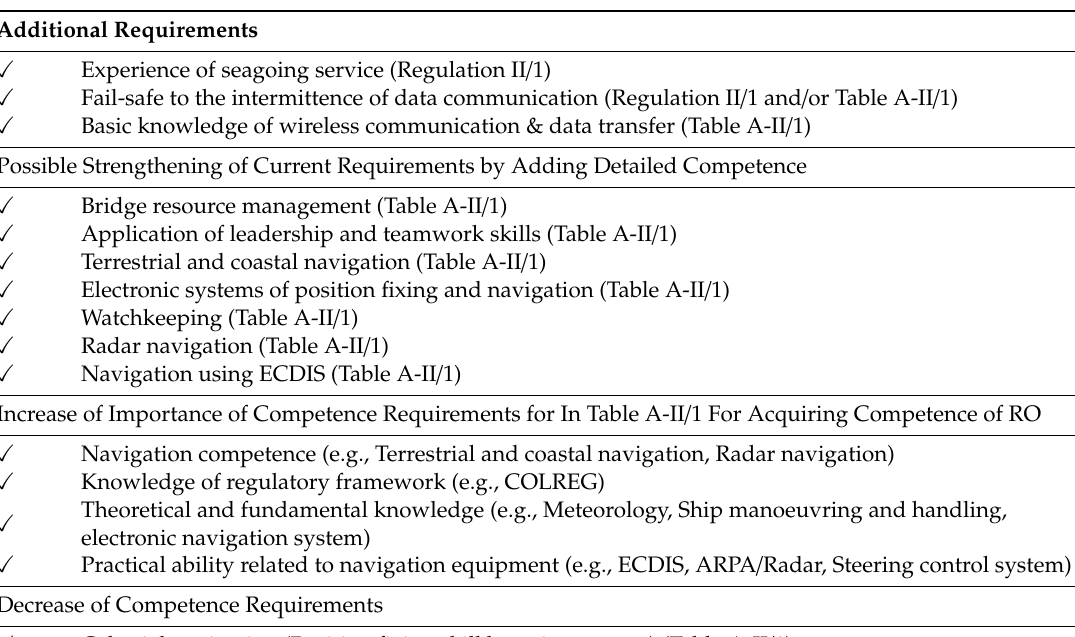
Table 12. Proposal on possible change on the STCW Convention